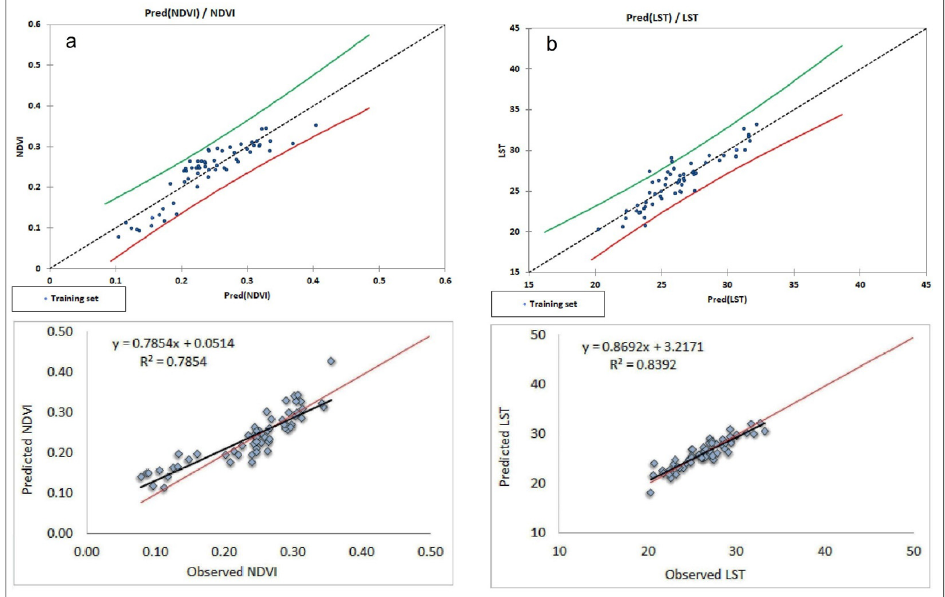
Figure 10. The Quantile–Quantile Plot (Q–Q Plot) of Observed ( a ) NDVI and ( b ) LST at 60 Locations Versus Predicted Values.